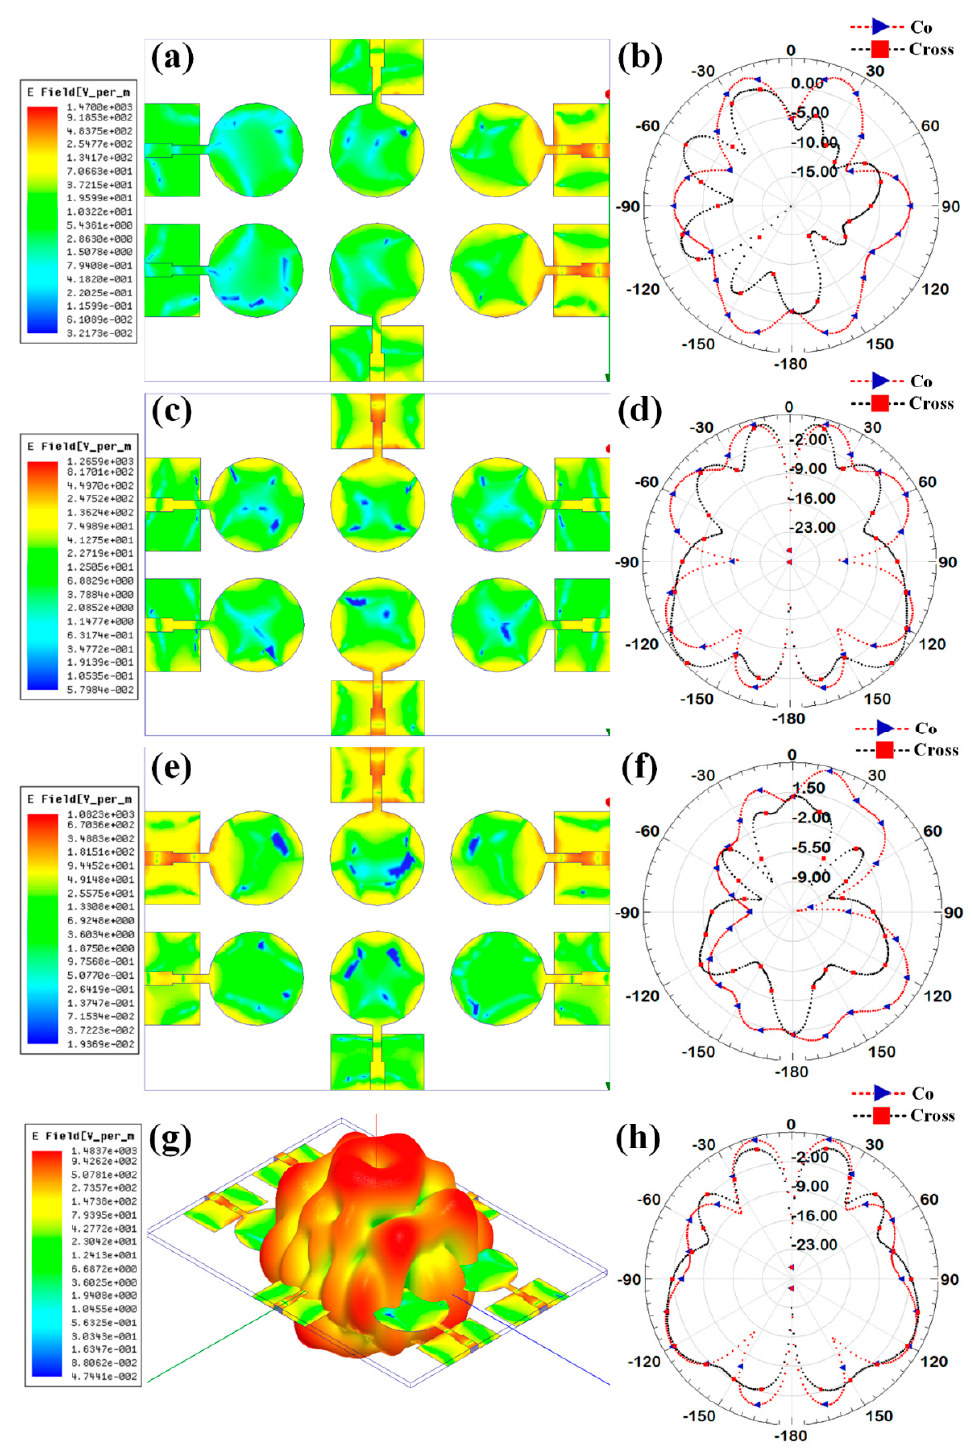
Figure 10. Electric field intensity and polar radiation pattern for the Design 4. Normalized electric field distribution for the different port excitation conditions such as ( a ) (P1 = 1, P2 = 1), ( c ) (P3 = 1, P6 = 1), and ( e ) (P1 = 1, P5 = 1, P6 = 1). Co-polarization and cross-polarization 2D radiation pattern for the di ff erent port excitation conditions such as ( b ) (P1 = 1, P2 = 1), ( d ) (P3 = 1, P6 = 1), and ( f ) (P1 = 1, P5 = 1, P6 = 1). ( g ) three-dimensional radiation pa tt ern along with the electric fi eld distribution for the all-port excitation conditions. ( h ) Co polarization and cross polarization 2D radiation pa tt ern for all port excitation conditions.